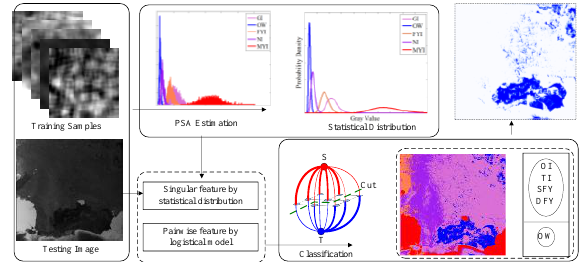
Figure 1. Framework of statistical distribution based ice-water classification